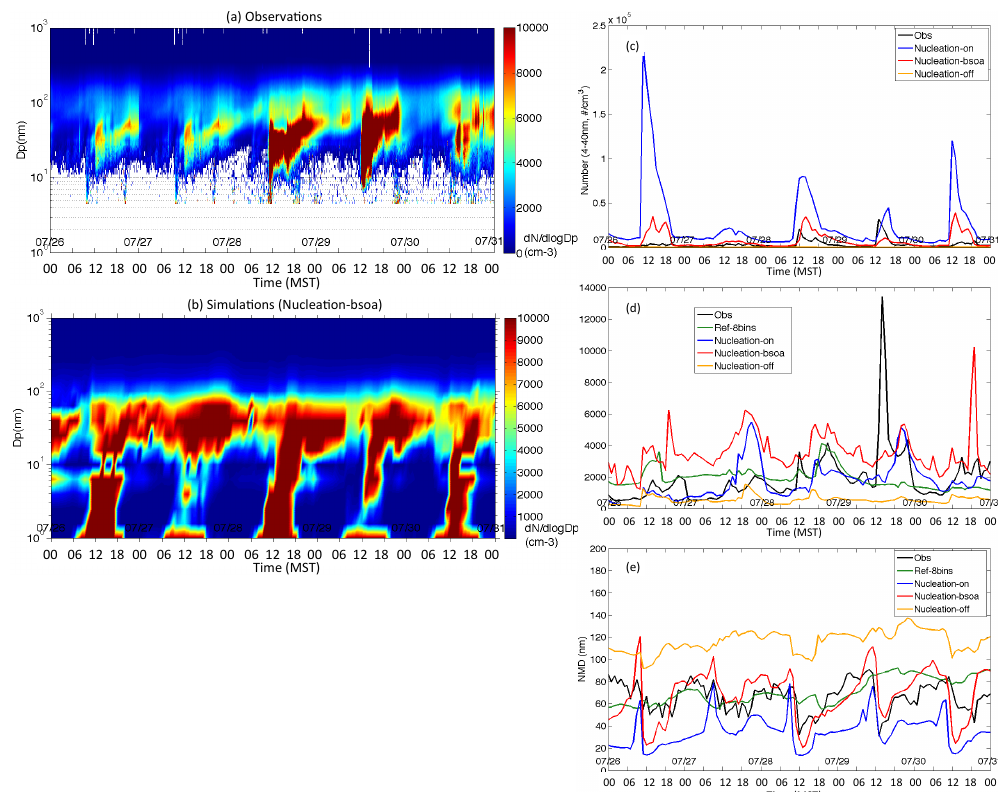
Figure 7: Temporal evolution of the (a) observed and (b) simulated (Nucleation-bsoa) number size distributions, during July 26-30, 2011. Time series of number concentrations of particles in size ranges of (c) 4-40nm and (d) 40-100nm, and (e) number mean diameter (NMD, see equation 1) as observed and predicted at the MEFO site. Measurements are indicated by the black line (OBS), base case is green, “Nucleation-on” is blue, “Nucleation-bsoa” is red, and “Nucleation-off” is orange, respectively (see Table 2 for the model run descriptions).